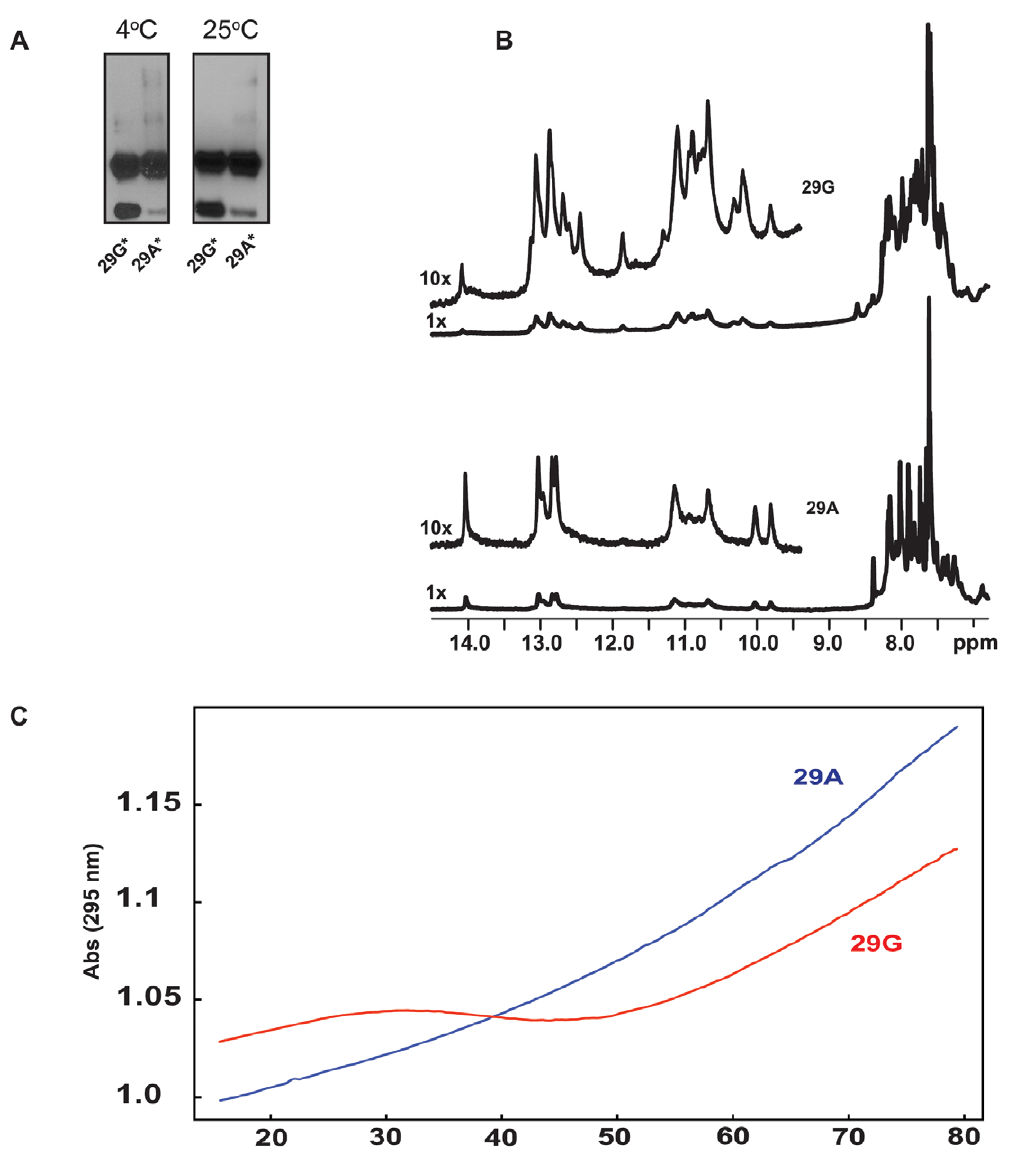
Figure 4. Higher-Order Structure in Duplex and Single Stranded Oligonucleotides. ( A ) 15% non-denaturing polyacrylamide gel electrophoresis of duplex oligos in the presence of 40 mM NaCl. The oligos were incubated in binding buffer (Materials and Methods) for 40 min and 20 min at 4 u C and 25 u C respectively. 29G* (Lanes1 and 3), 29A* (Lanes 2 and 4) are at 4 u C and 25 u C respectively. ( B ) 1D proton NMR spectra (imino, amino and aromatic signal regions) of oligonucleotides 29G (top) and 29A (bottom) in the presence of 40 mM Na + , 10 mM phosphate, pH 7.0. ( C ) Denaturation profiles of single stranded oligos 29G (red) and 29A (blue) at 295 nm wavelength. Experimental conditions: 40 mM Na + , 10 mM phosphate, pH 7.0.